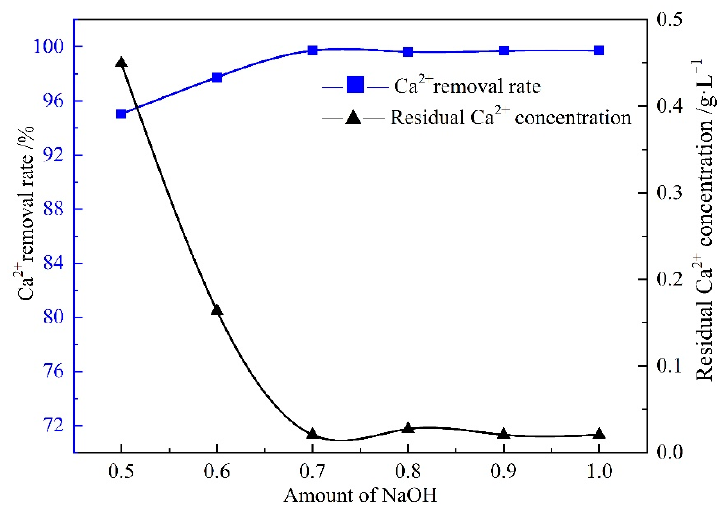
Figure 6. The relationship between the amount of NaOH added and the removal rate of Ca 2+.